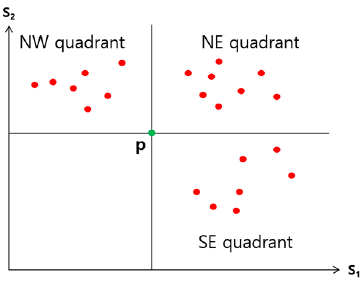
Figure 5. Anchor point. Figure 5. Anchor